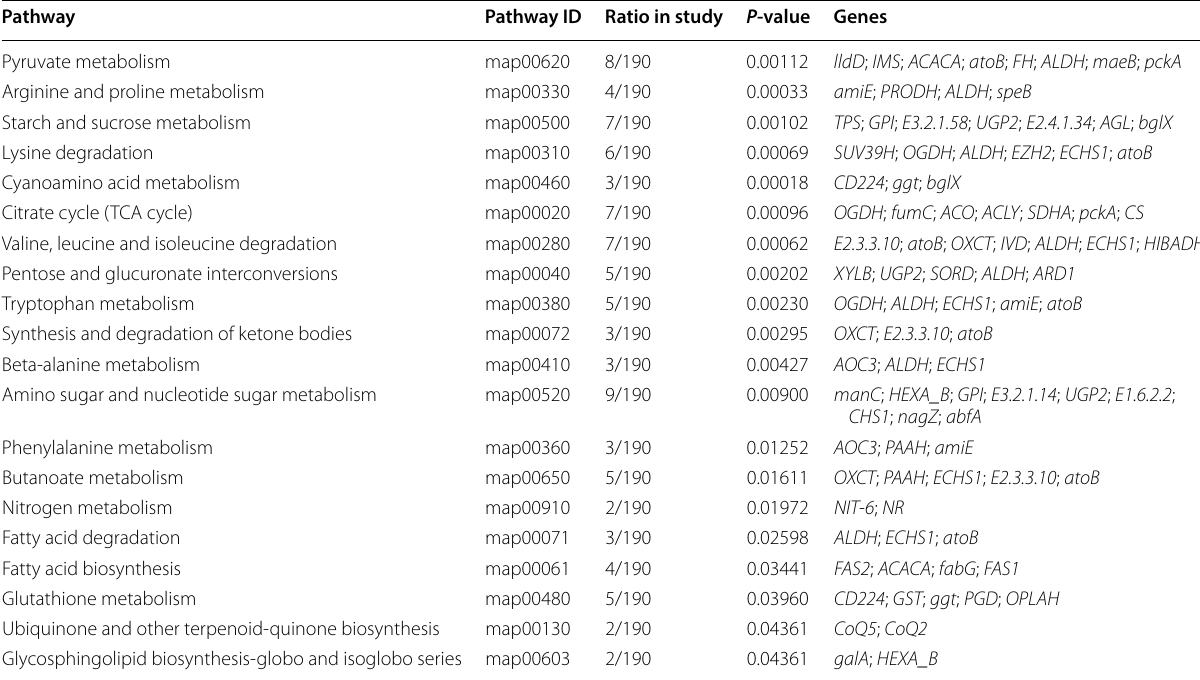
Table 1 Annotations of the KEGG pathway for DEGs on day 10